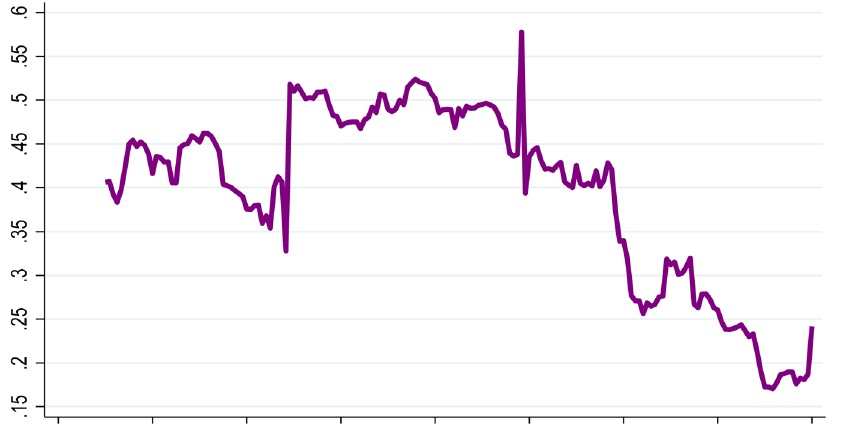
Fig. 4 Rolling window Frankel–Wei regressions